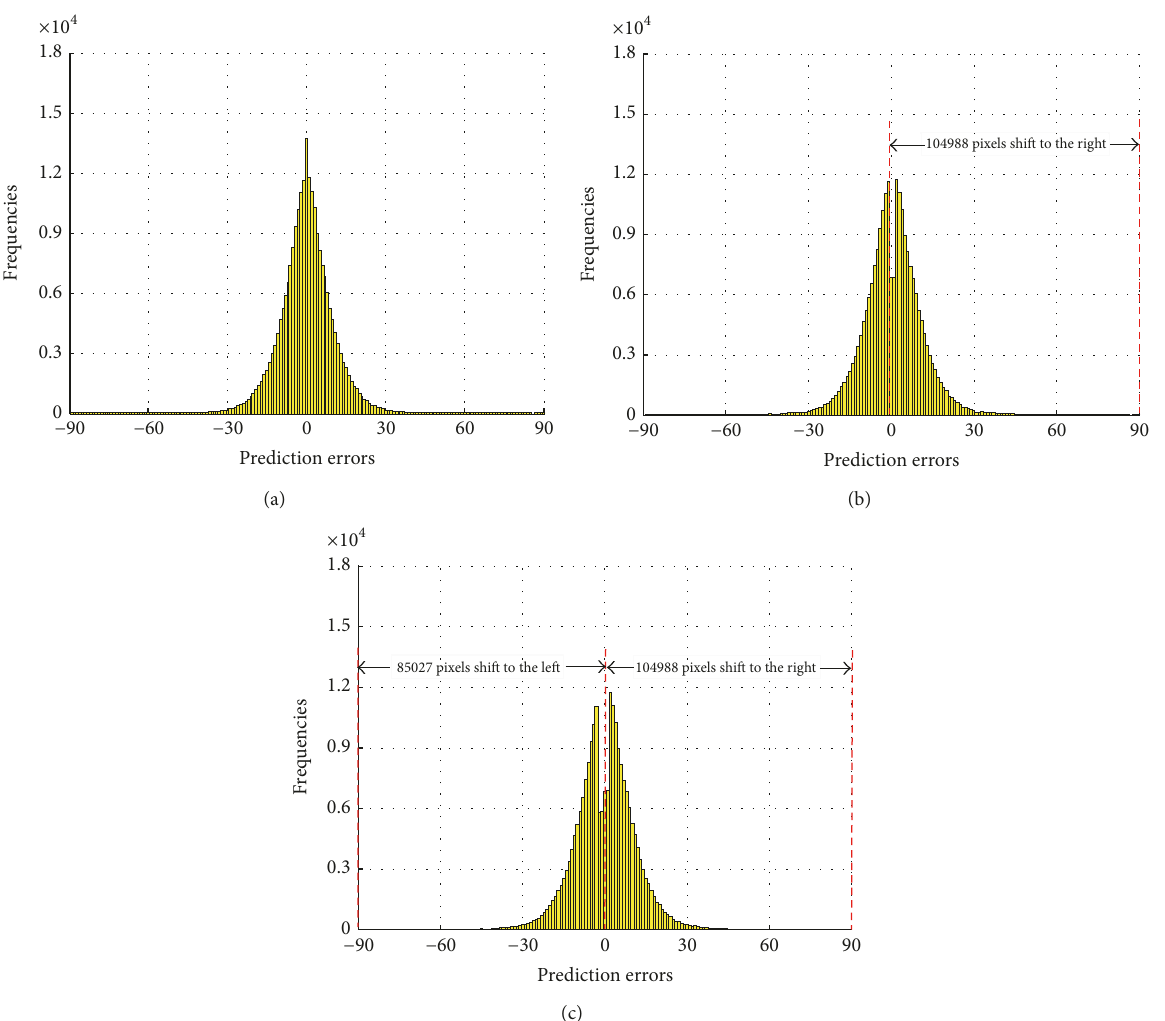
Figure 1: (a) Symmetric histogram; (b) embedded peak point; (c) embedded peak and previous peak points.